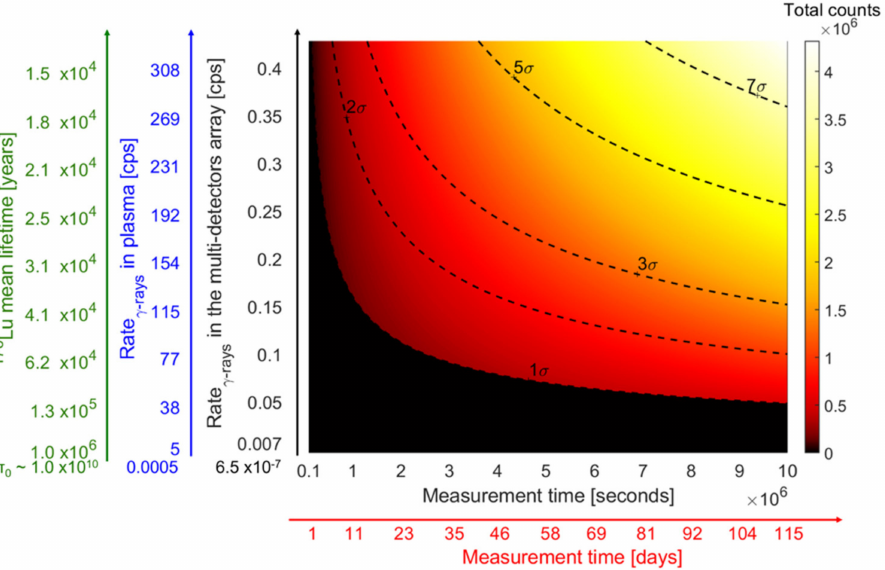
Figure 8. Measurability plot reporting the confidence levels that it is possible to obtain vs. the decay rate (or the lifetime) of the 176 Lu and the measurement